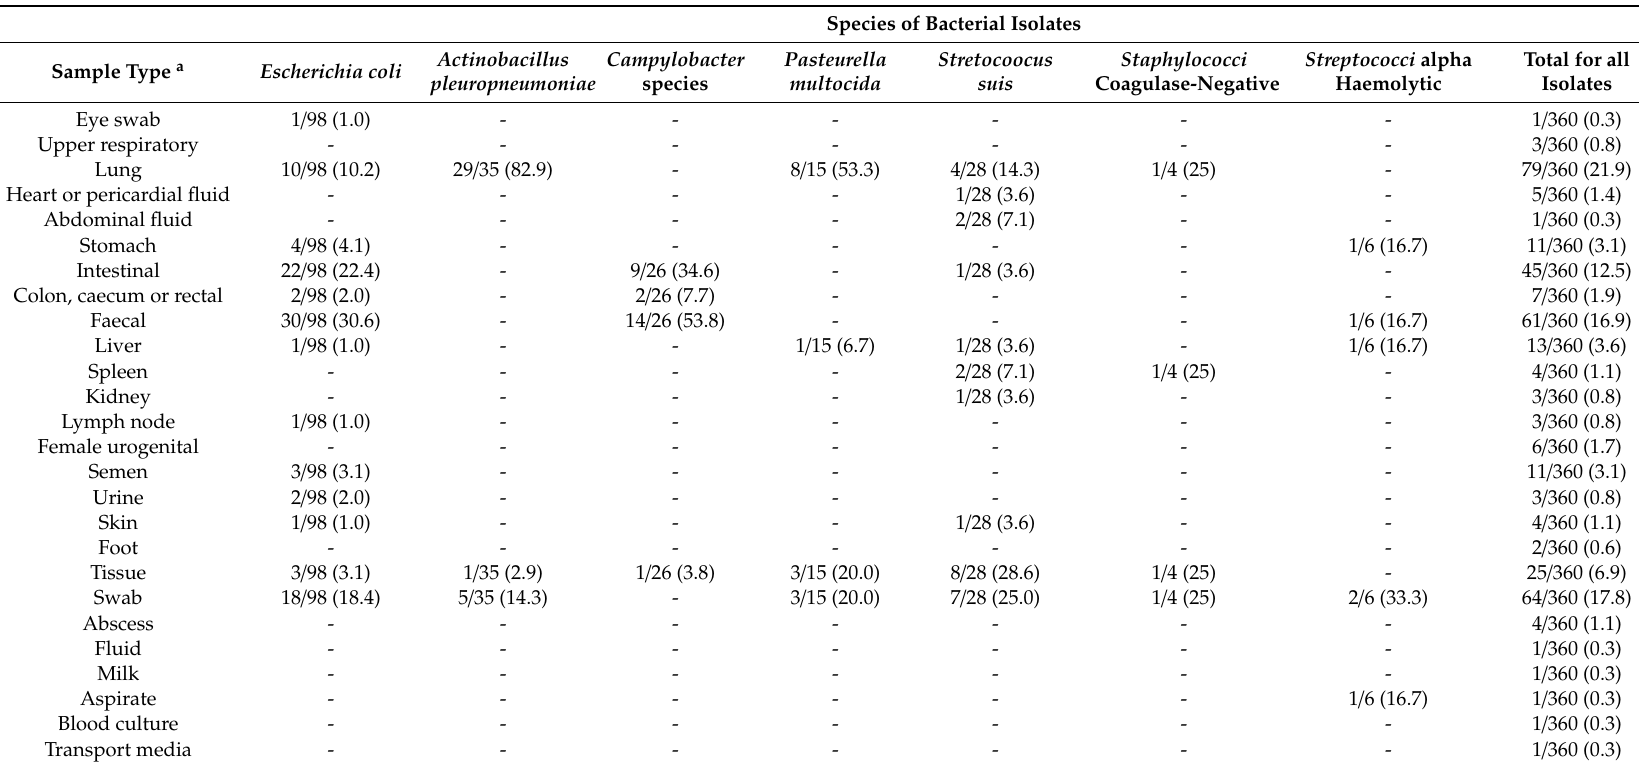
Table 1. Sample sites for the seven most common bacterial isolates cultured from porcine samples. The percentage of total isolates for each isolate type by sampling site are shown in